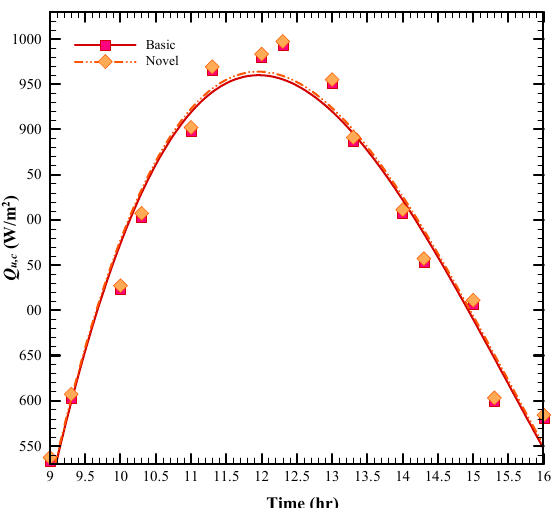
Figure 12. Variation of absorbed energy for a basic system without a turbulator and novel PTSC equipped with a turbulator and filled with nanofluid at ϕ = 0.019% and Re = 5000 versus different times of day.